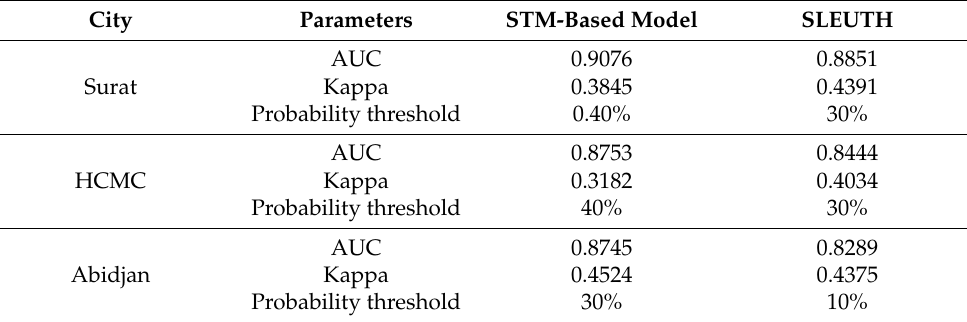
Table 4. Comparison between results of the STM-based model and results of SLEUTH. Results from the STM-based model were generated with the ten-year strategy based on